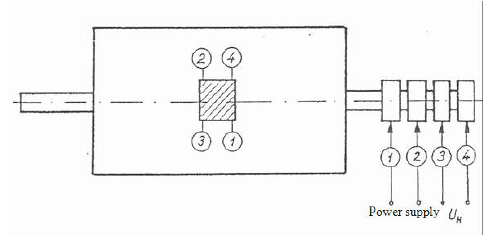
Figure 7. Connections of the Hall sensor placed on the rotor.